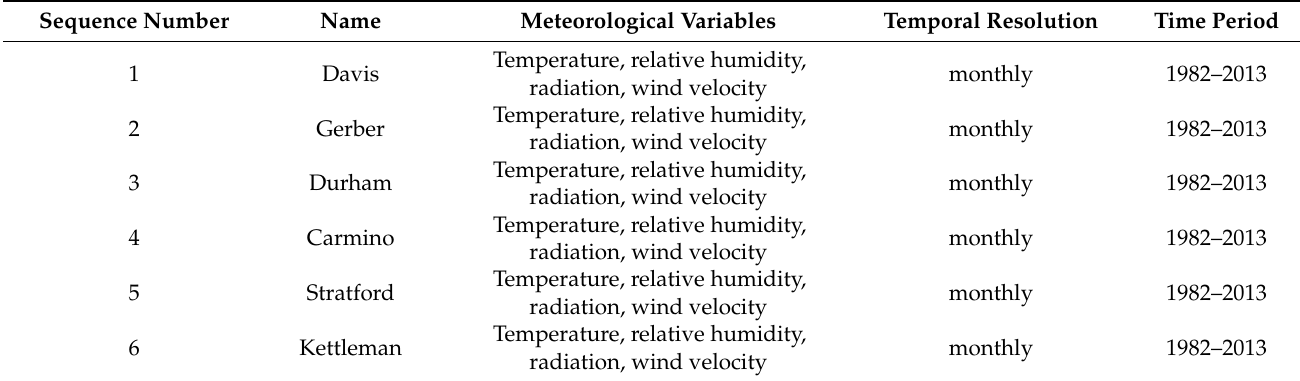
Table 1. Information on the selected